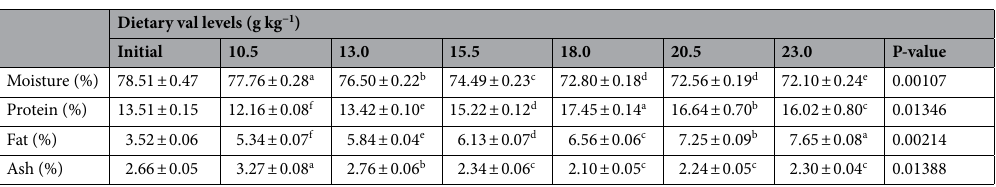
Table 2. Carcass composition of rainbow trout, Oncorhynchus mykiss fingerlings fed diets containing varying levels of dietary valine for 8-weeks (mean values of 3 replicates + SEM; n = 3) *